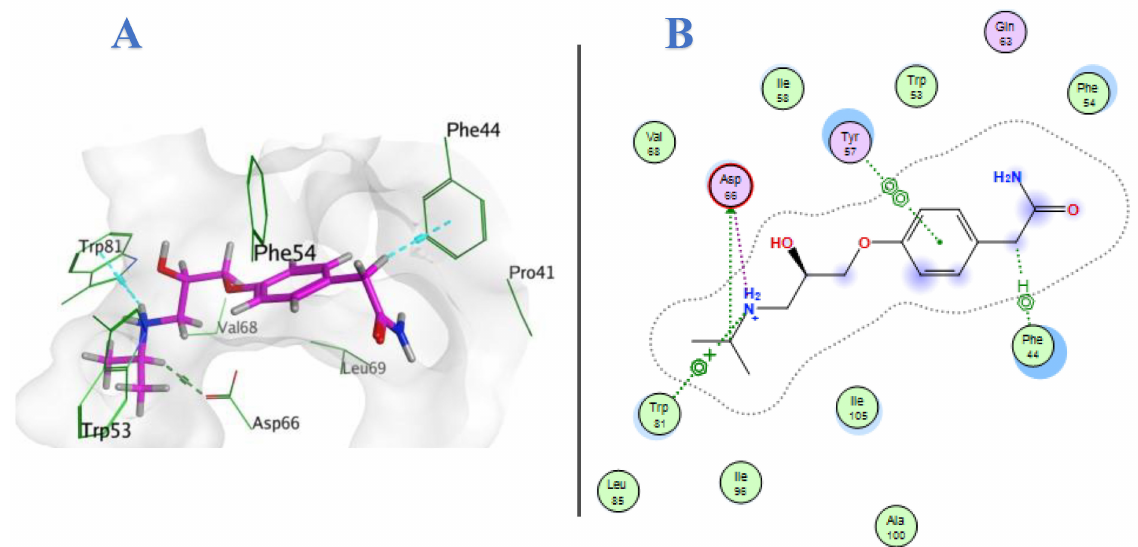
Figure 7. ( A ) 3D Atenolol- S. marcescens SmaR model interaction diagram, Atenolol is in purple thick sticks within the molecular surface of the active site, amino acid residues of the active site are shown as green thin sticks. H-bond is presented as green dots. Pi -bond is presented as turquoise dots, ( B ) 2D ligand interactions between atenolol and the key amino acid